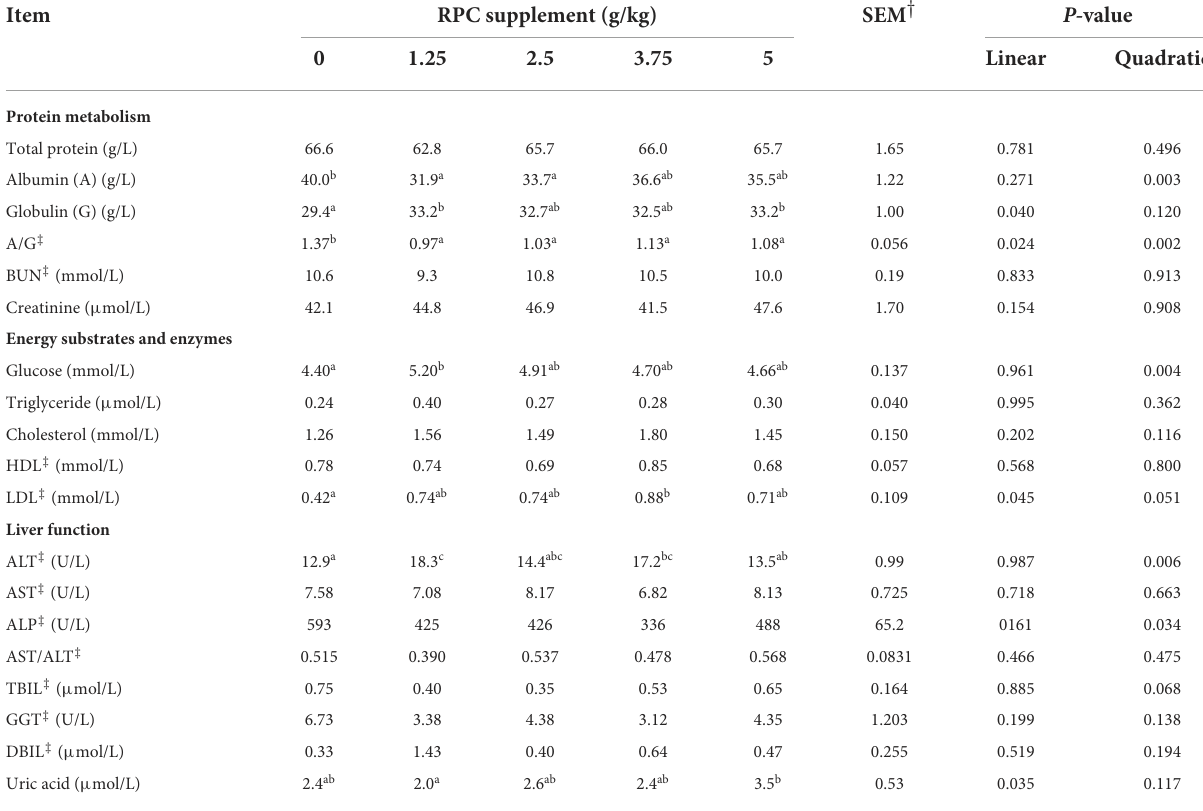
TABLE 5 Serum biochemical parameters of fattening lambs fed experimental diets supplemented with nil (CON) or rumen-protected choline (RPC) ( n = 6 per